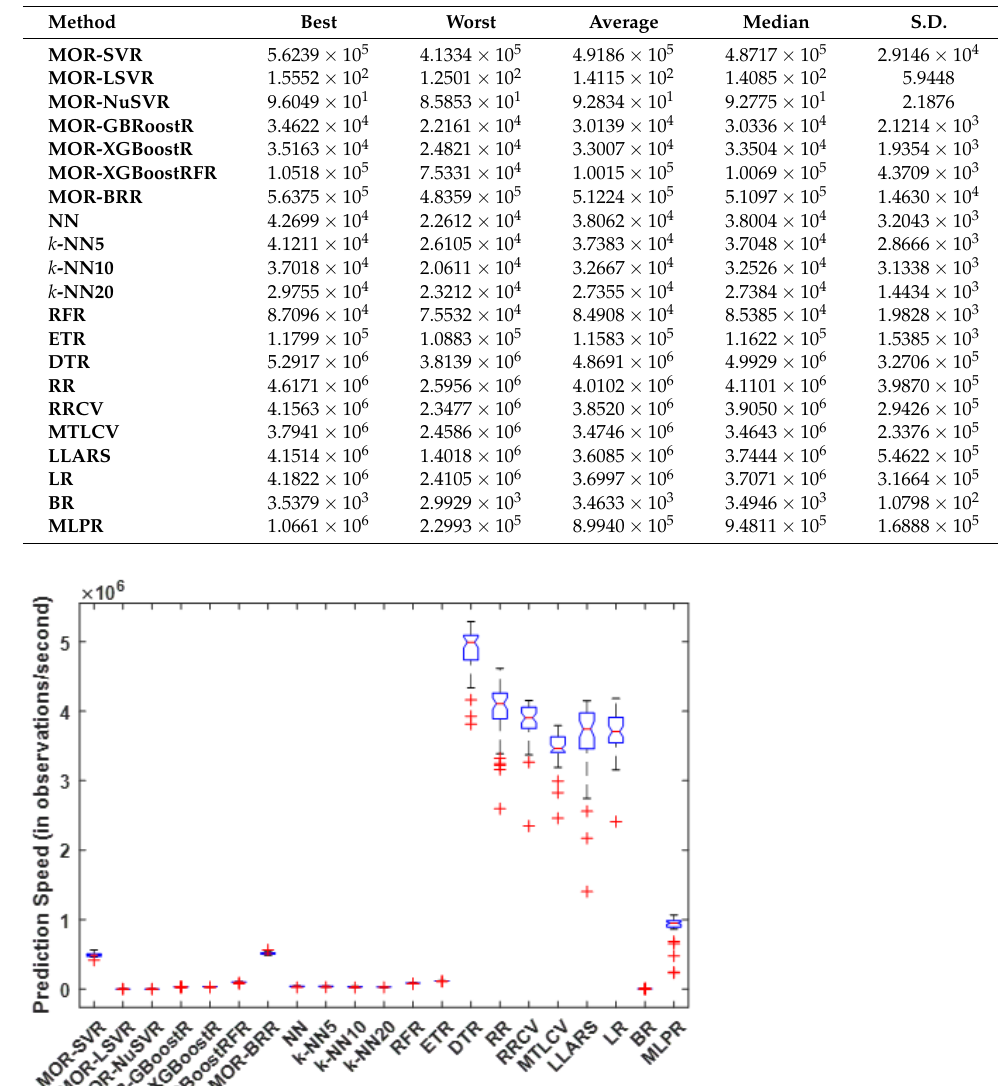
Table 6. Prediction speed (in observations per second (obs/s)) for all methods over 50 statistical runs (first stage).